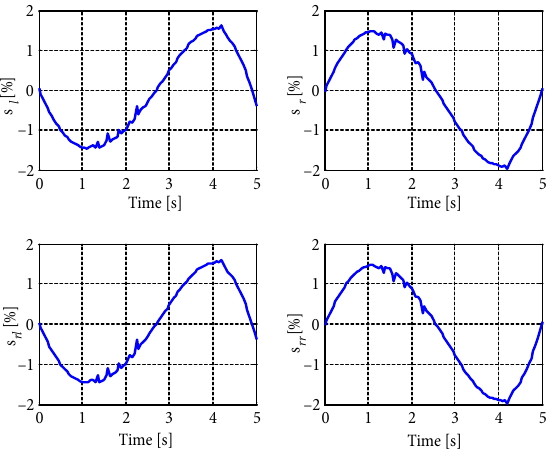
Fig. 13. Tracking trajectory comparison (right-angle turn